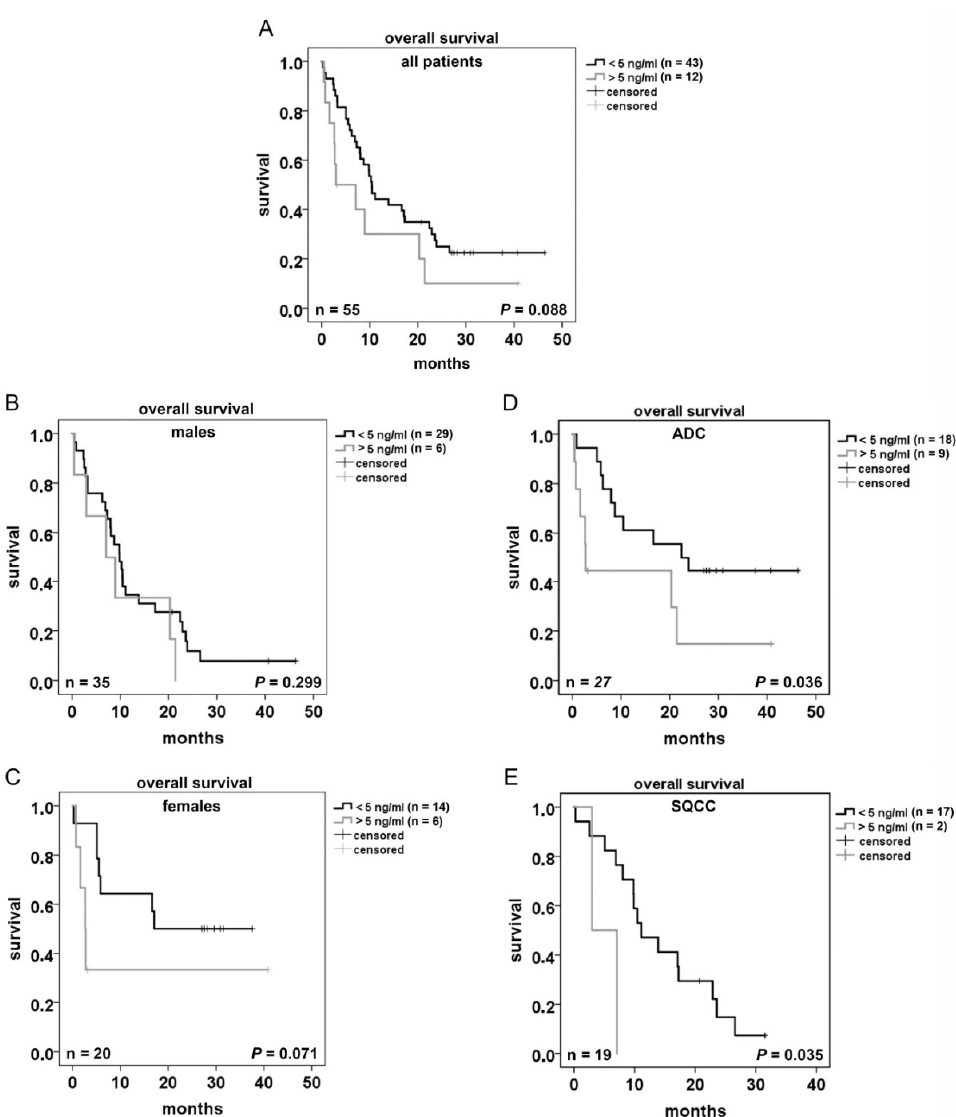
Figure 4. Prognostic potential of glycodelin serum concentrations in NSCLC advanced stage patients. ( A – E ) Kaplan-Meier curves using 5 ng/mL glycodelin serum concentration as the value to separate the patients in two groups. ADC = adenocarcinoma, SQCC = squamous cell carcinoma. p < 0.05 was considered as significant, n = number of patients.